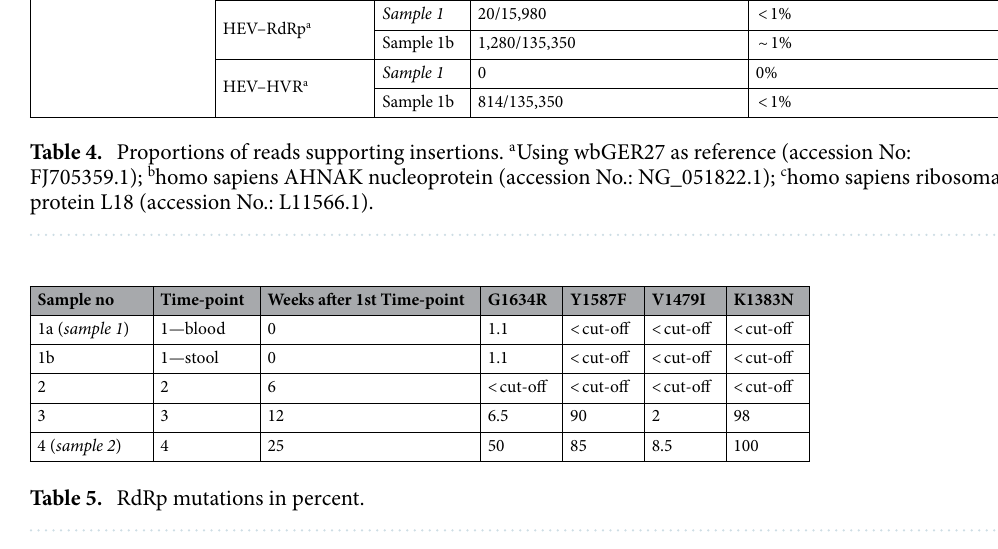
Table 5. RdRp mutations in percent.